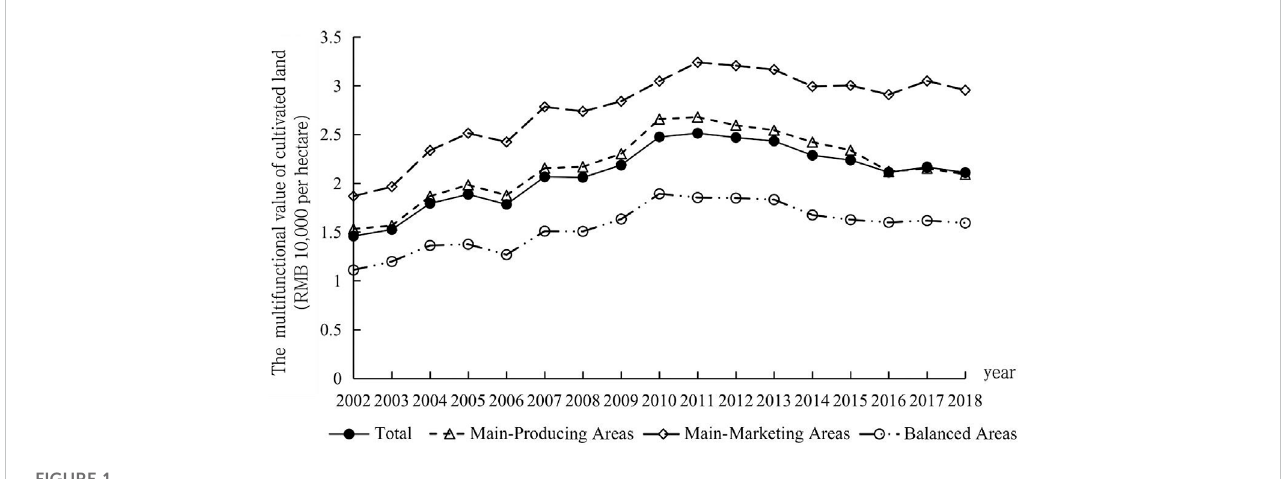
FIGURE 1 Trend of multifunctional change of cultivated land in 2002 –